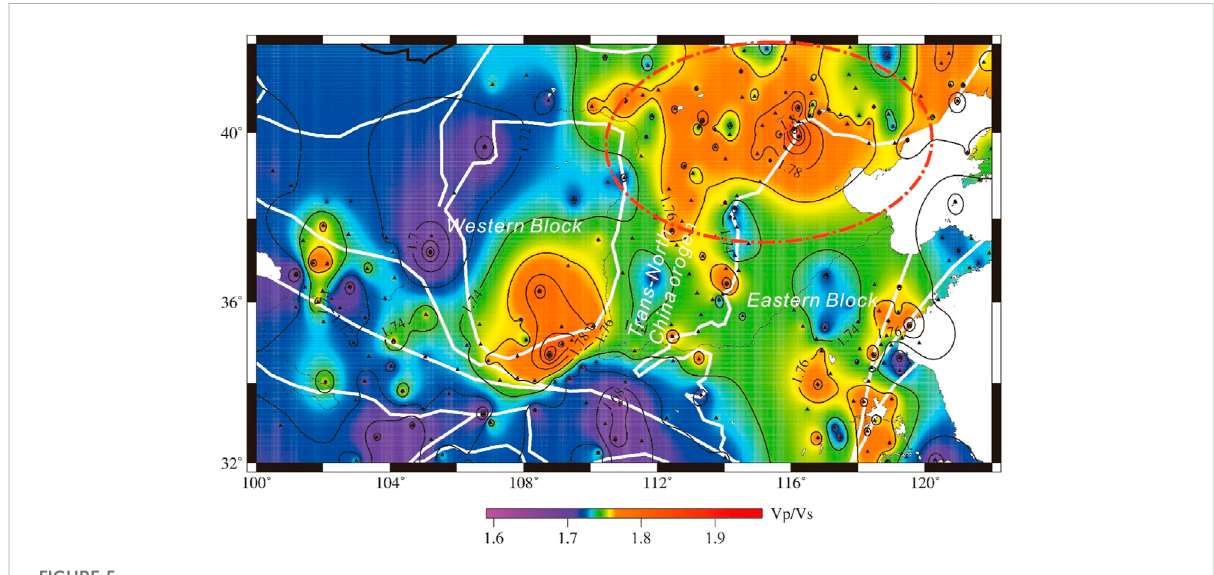
FIGURE 5 Distribution of the Vp/Vs. ratio in the NCC. Red oval: underplating region, which has higher Vp/Vs. ratios (Vp/Vs. ratio is greater than 1.76) (He et al., 2015).